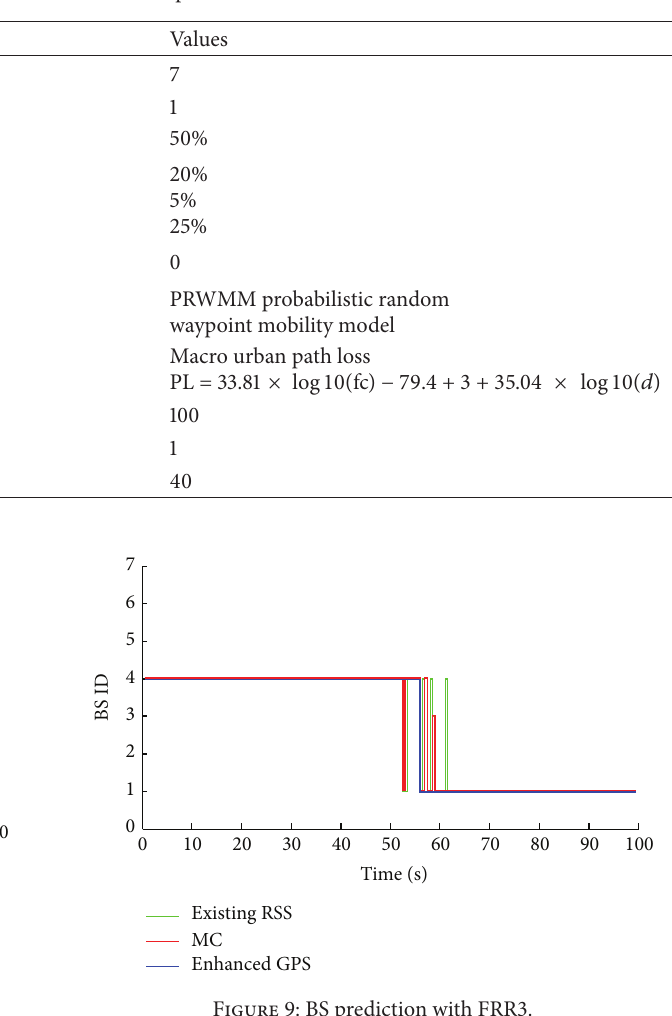
Table 1: Overall scenario of simulation parameters.